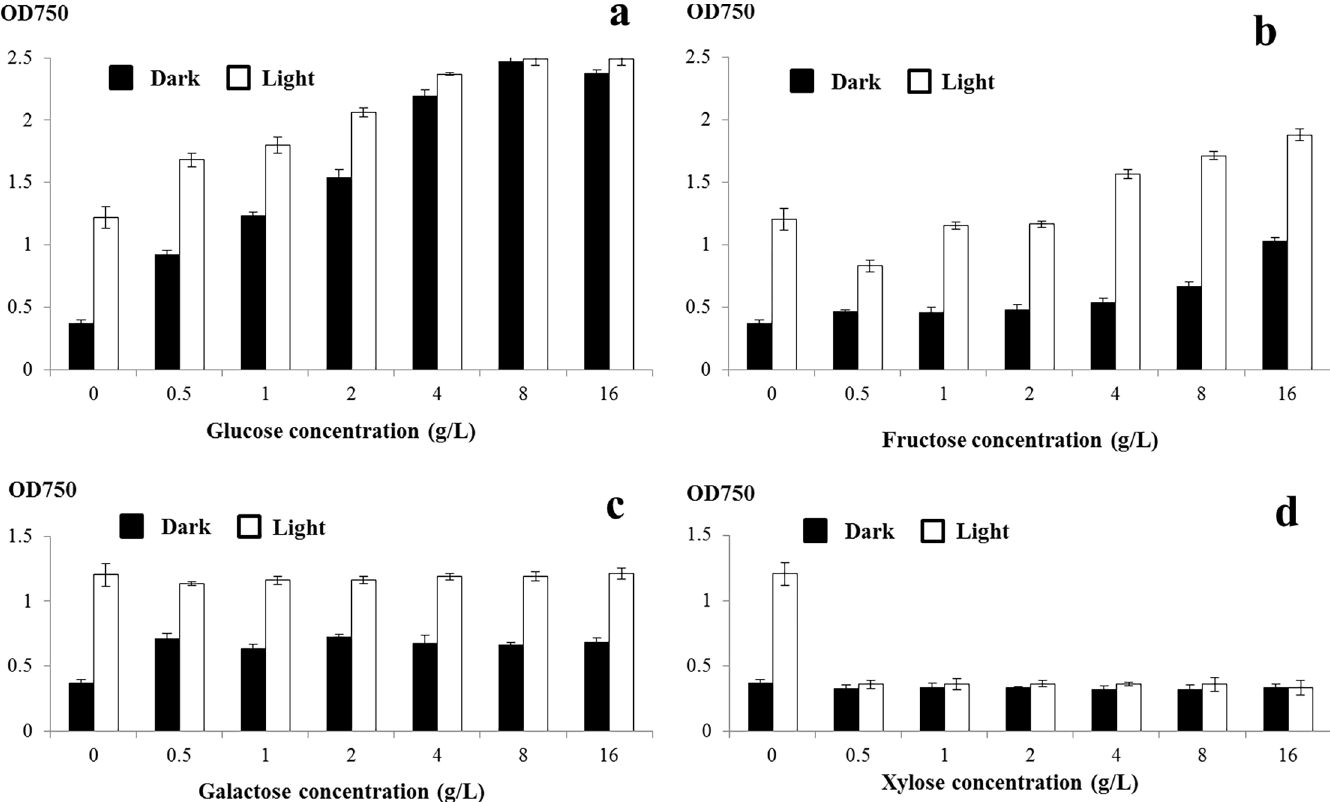
Fig 3. Cell density alterations to Chlorella sorokiniana UTEX 1230 grown in monosaccharide-supplemented medium. The density of C . sorokiniana UTEX 1230 cells collected after 7 days culture in monosaccharide-supplemented medium were determined by spectrophotometry at 750 nm. a, b, c, and d show cell densities following culture in glucose-, fructose-, galactose- and xylose-supplemented media, respectively. Data shown as mean +/-SD, n = 3. Black bar: dark conditions; white bar: light conditions.